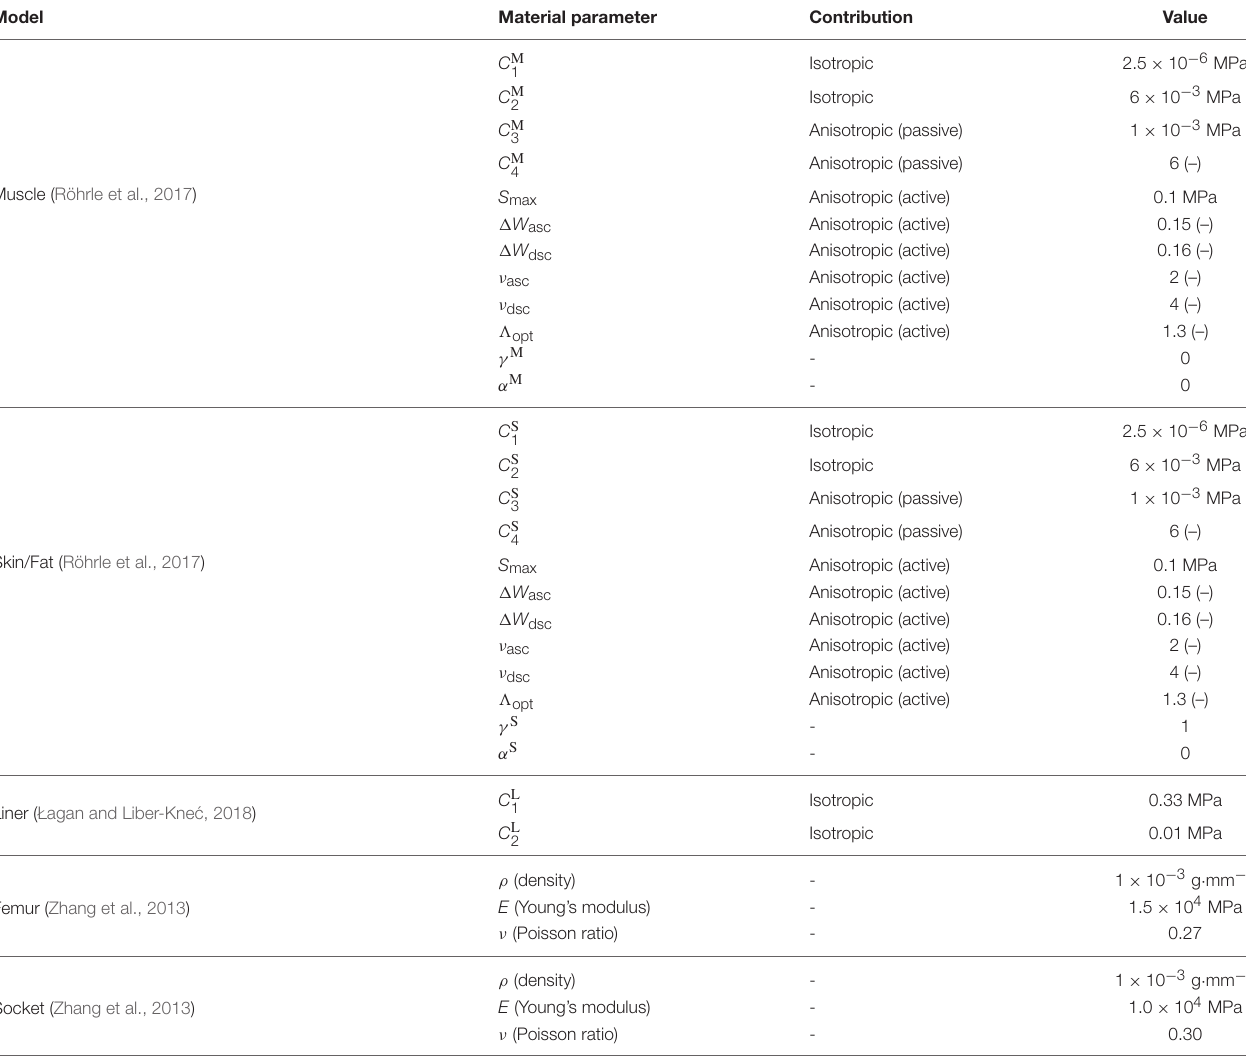
TABLE 1 | Material parameter table. Model Material